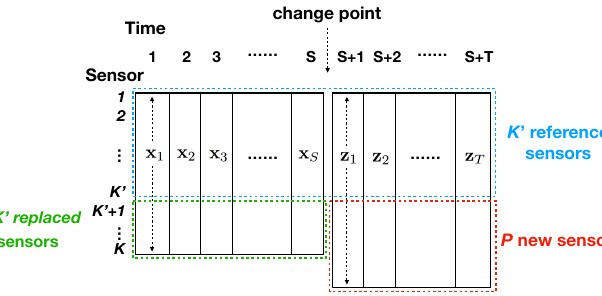
Figure 2. Settings and notations for sensor failures and